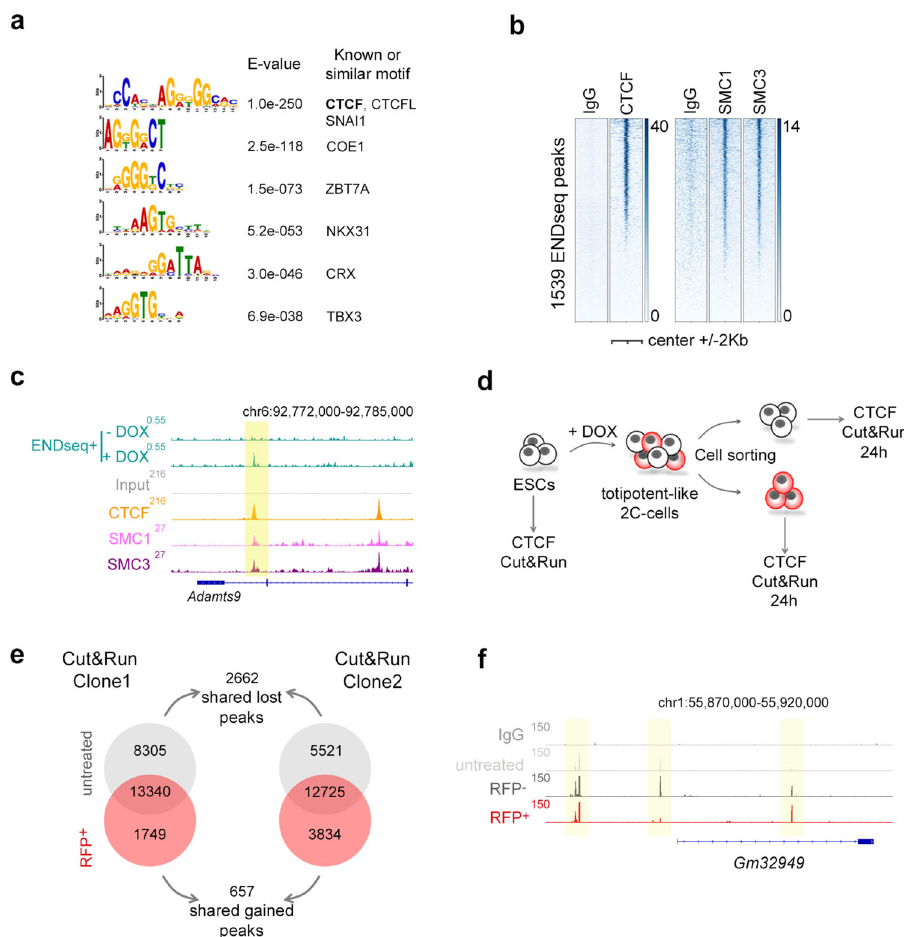
Fig. 2 DUX expression is associated with DNA damage at a subset of CTCF binding sites. a Results from a motif enrichment analysis performed on the set of overlapping 1539 END-seq sites identi fi ed in DUX-expressing ESC. b Heatmaps showing CTCF 20 , SMC1 and SMC3 21 occupancy at the set of 1539 END-seq sites. c Genome browser tracks showing END-seq signal in untreated and DOX-treated ESC DUX at the indicated genome location. In addition, CTCF 20 , SMC1 and SMC3 21 occupancy in ESC is shown. END-seq peak is highlighted. d Schematic representation of the experiment performed. e Venn diagram showing the number of CTCF peaks detected in untreated and RFP + sorted cells from two independent DOX-treated ESC DUX clones. The number of overlapping shared gained and lost CTCF peaks is also shown. f Genome browser tracks showing CTCF occupancy at the indicated genome location in one representative ESC DUX clone. Input (IgG) is shown as a background reference control. Note how in the region shown, one CTCF peak is gained and one lost in RFP + cells. In all cases, 600 ng/mL DOX was